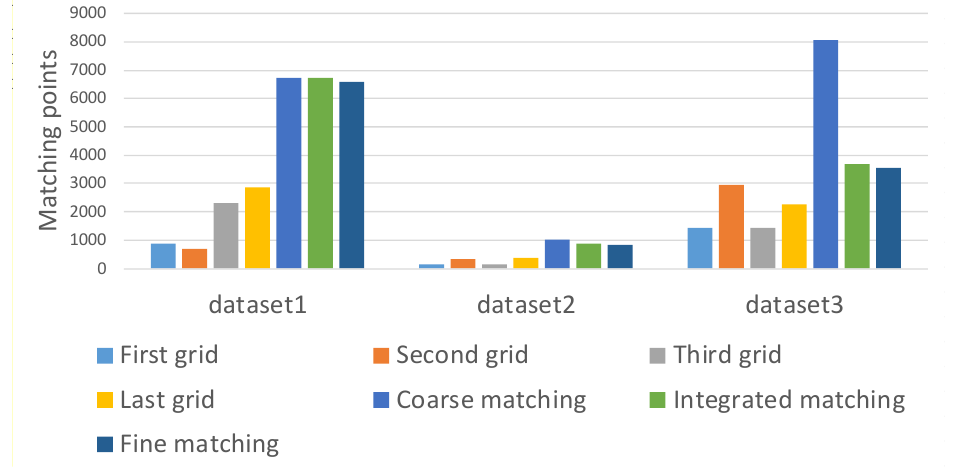
Figure 11. Statistics on the matching points.